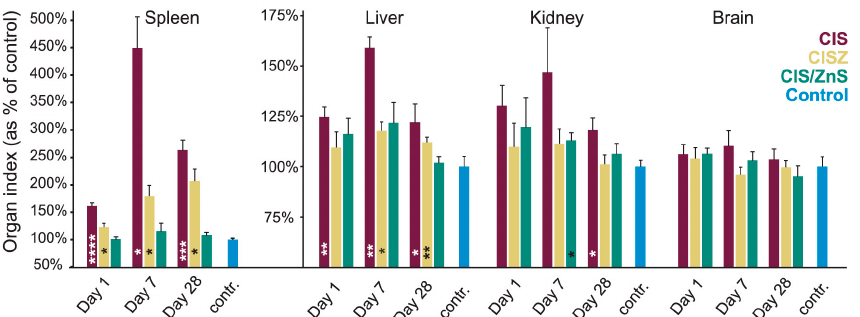
Figure 12. Organ index (organ weight/total body weight) plotted as the percent of control values for four major organs [101].